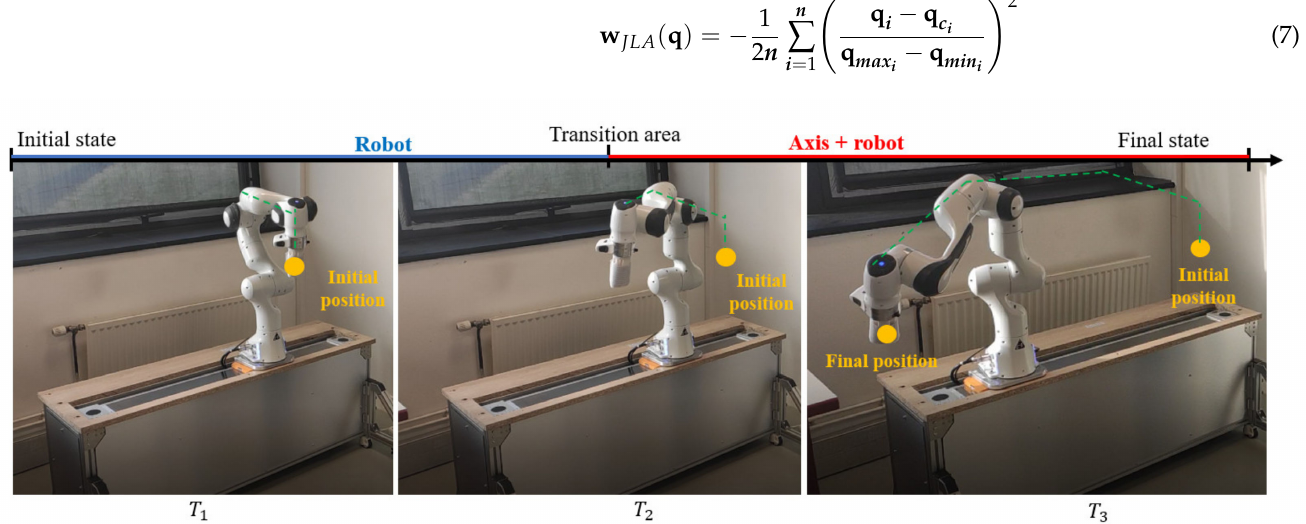
Figure 14. Switching robot/axis motion strategy. During a linear trajectory, the robot is initially activated to execute the desired motion. Once Xlim is reached (transition area), the axis is activated instead of the robot to execute the motion along the Y-axis (the robot keeps moving along the remaining